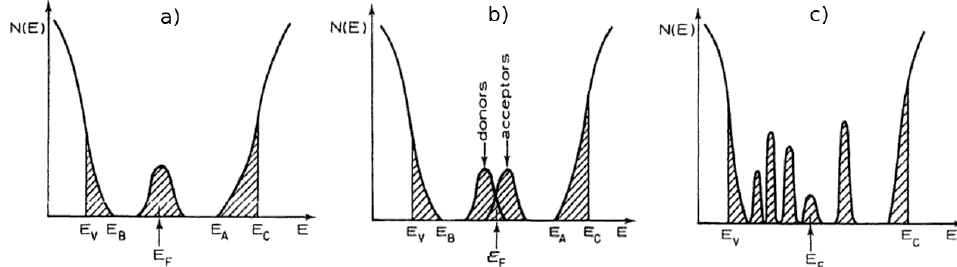
Figure 3. Density of states for amorphous solids: ( a ) the Davis-Mott model, showing a band of compensated levels near the middle of the gap; ( b ) the Marshall-Owen model with donor/acceptor bands in the middle of the gap; ( c ) a “real” glass with defect states. (Reprint with permission from Brodsky M.H. Amorphous Semiconductors , 2nd ed.; Springer-Verlag, Berlin, Germany, 1979, 357–393; ISBN. 978-0387160085, [53]).